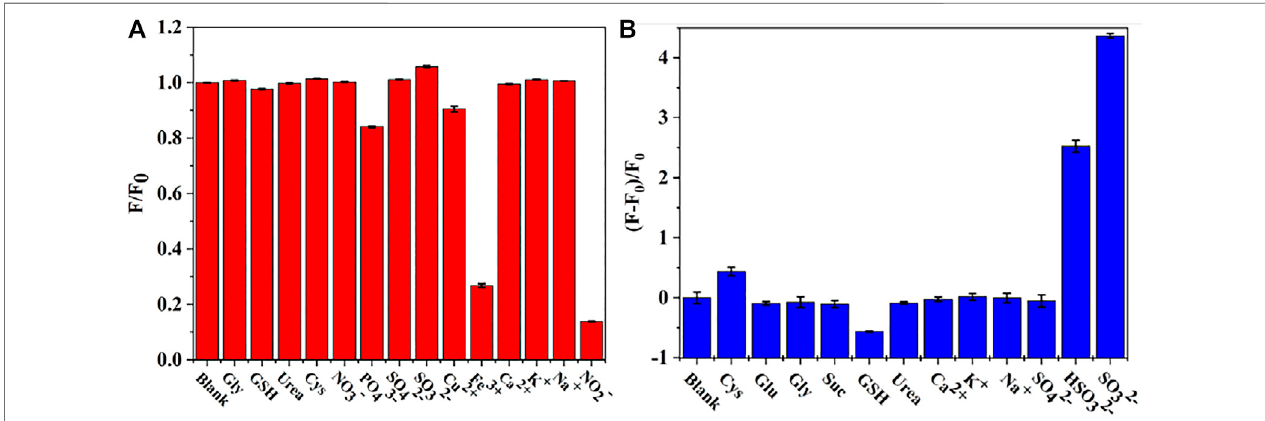
FIGURE 6 | (A) Selective test of the assay toward NO 2- (B) Selectivity in the sensing response of CDs/NO 2- toward SO 32- .